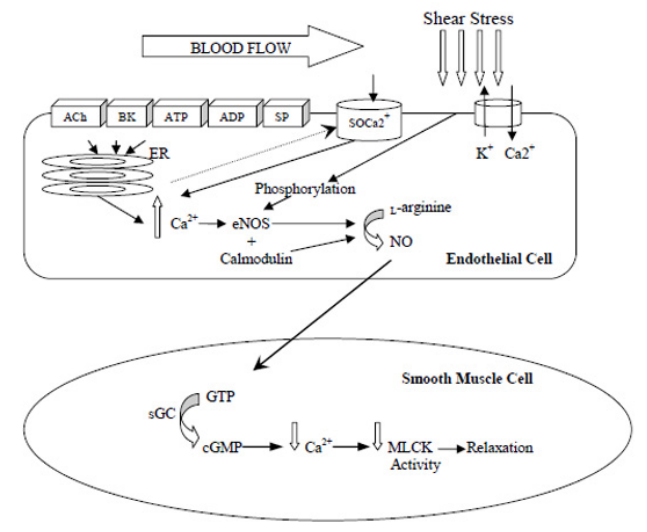
Figure 1. Endothelial nitric oxide production and it actions in the vascular smooth muscle cell.